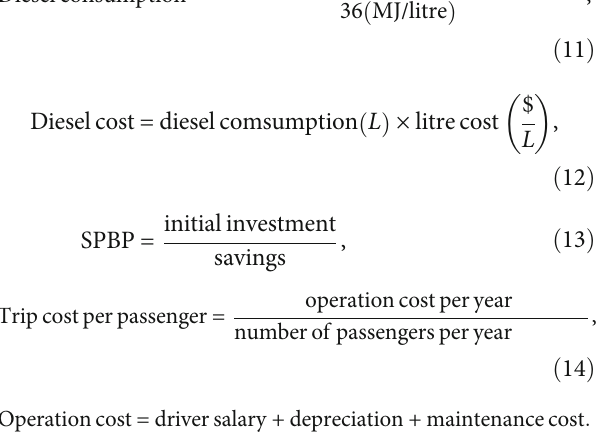
Figure 8: Discharging demand of the third